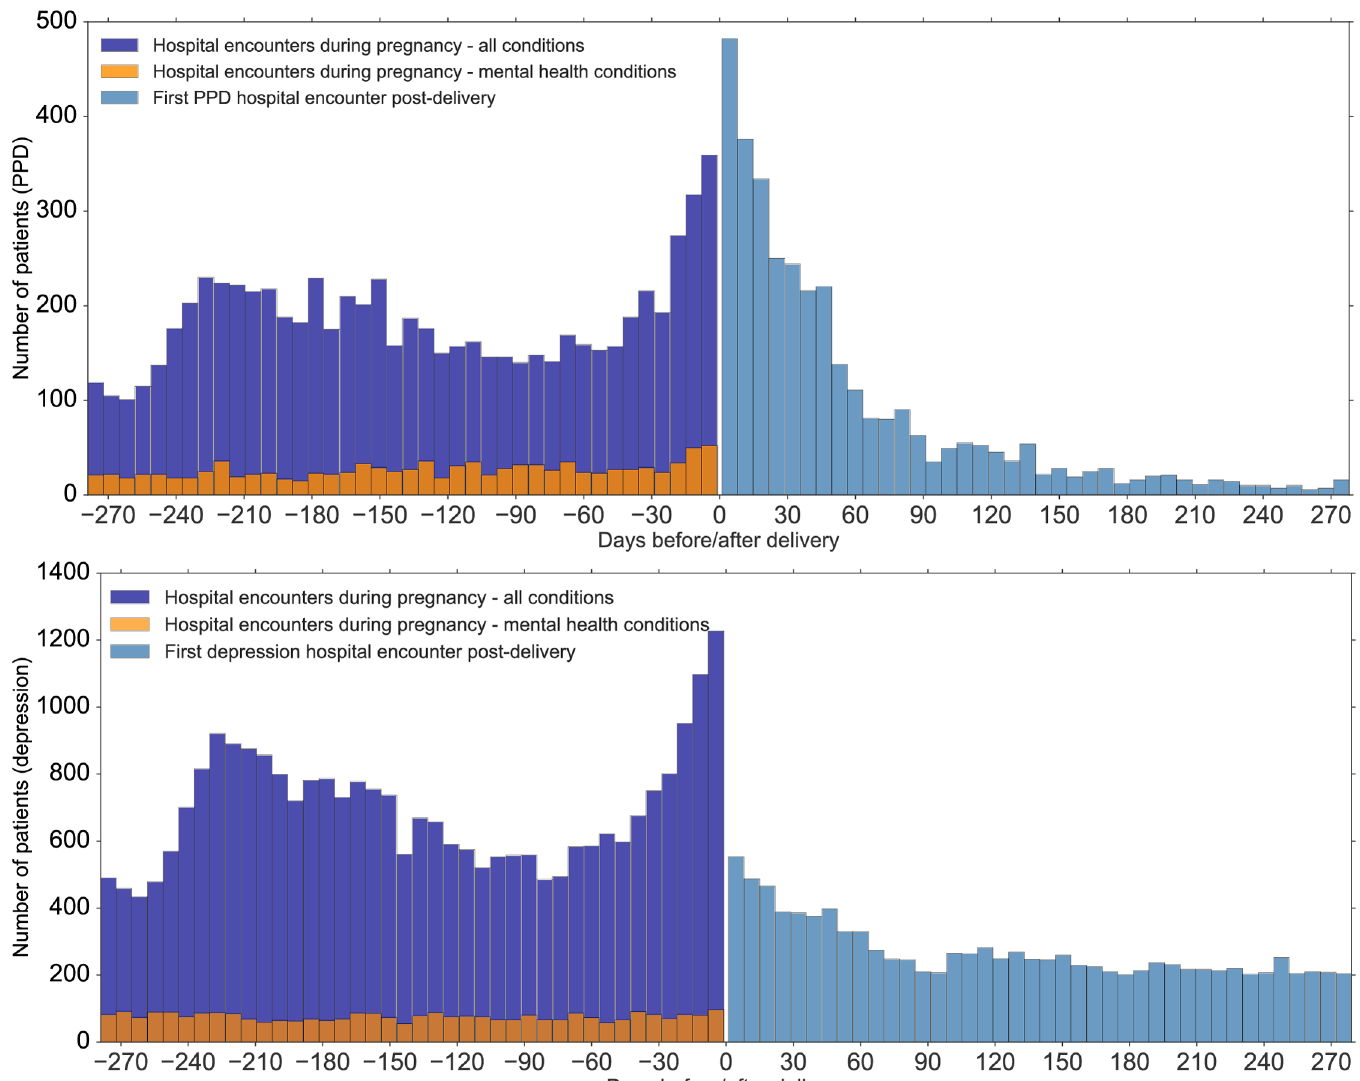
Fig 3. ( Top panel ) Histogram of hospital encounters among women who were assigned specific postpartum depression ICD9-CM codes. To the left of zero are visits for all causes prior to delivery and to the right of zero are visits at which the diagnosis of PPD was first assigned. Patients diagnosed with depression in the 9 months after the delivery (light blue bars) are admitted and/or visit the ED department for a diverse set of conditions during pregnancy (dark blue bars), including mental health conditions (dark orange bars). The majority of specific PPD diagnoses are assigned in the first months after delivery, with a long tail of small numbers thereafter. ( Bottompanel ) : A similar histogram for all women with depression (see text). Although a specific PPD diagnosis is less common, first visits for depression continue steadily.